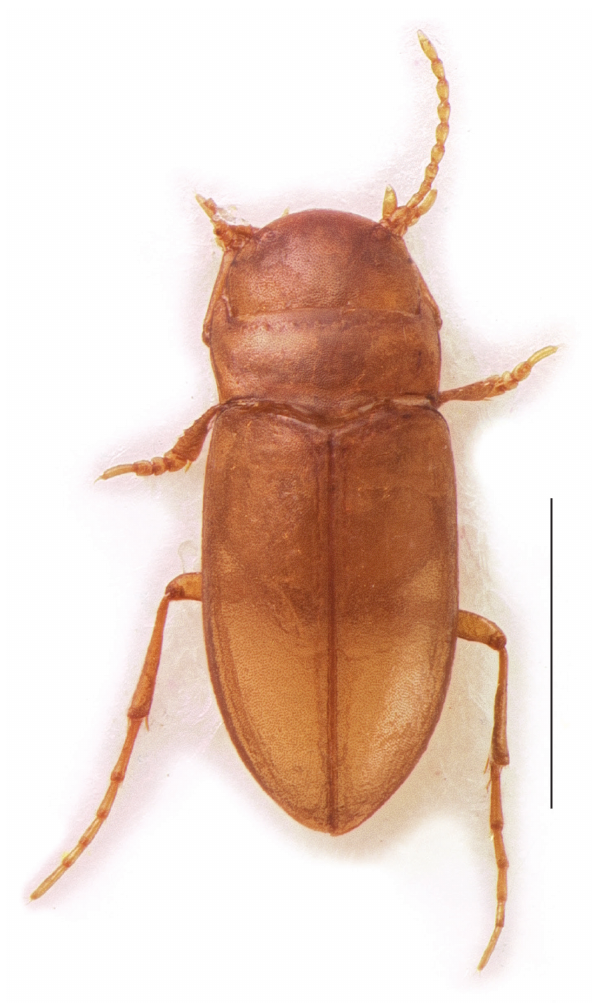
Figure 1. Dorsal habitus of female Stygoporus oregonensis . Scale bar = 1 mm. methods, the placement of three of the four described Texas stygobitic dytiscids